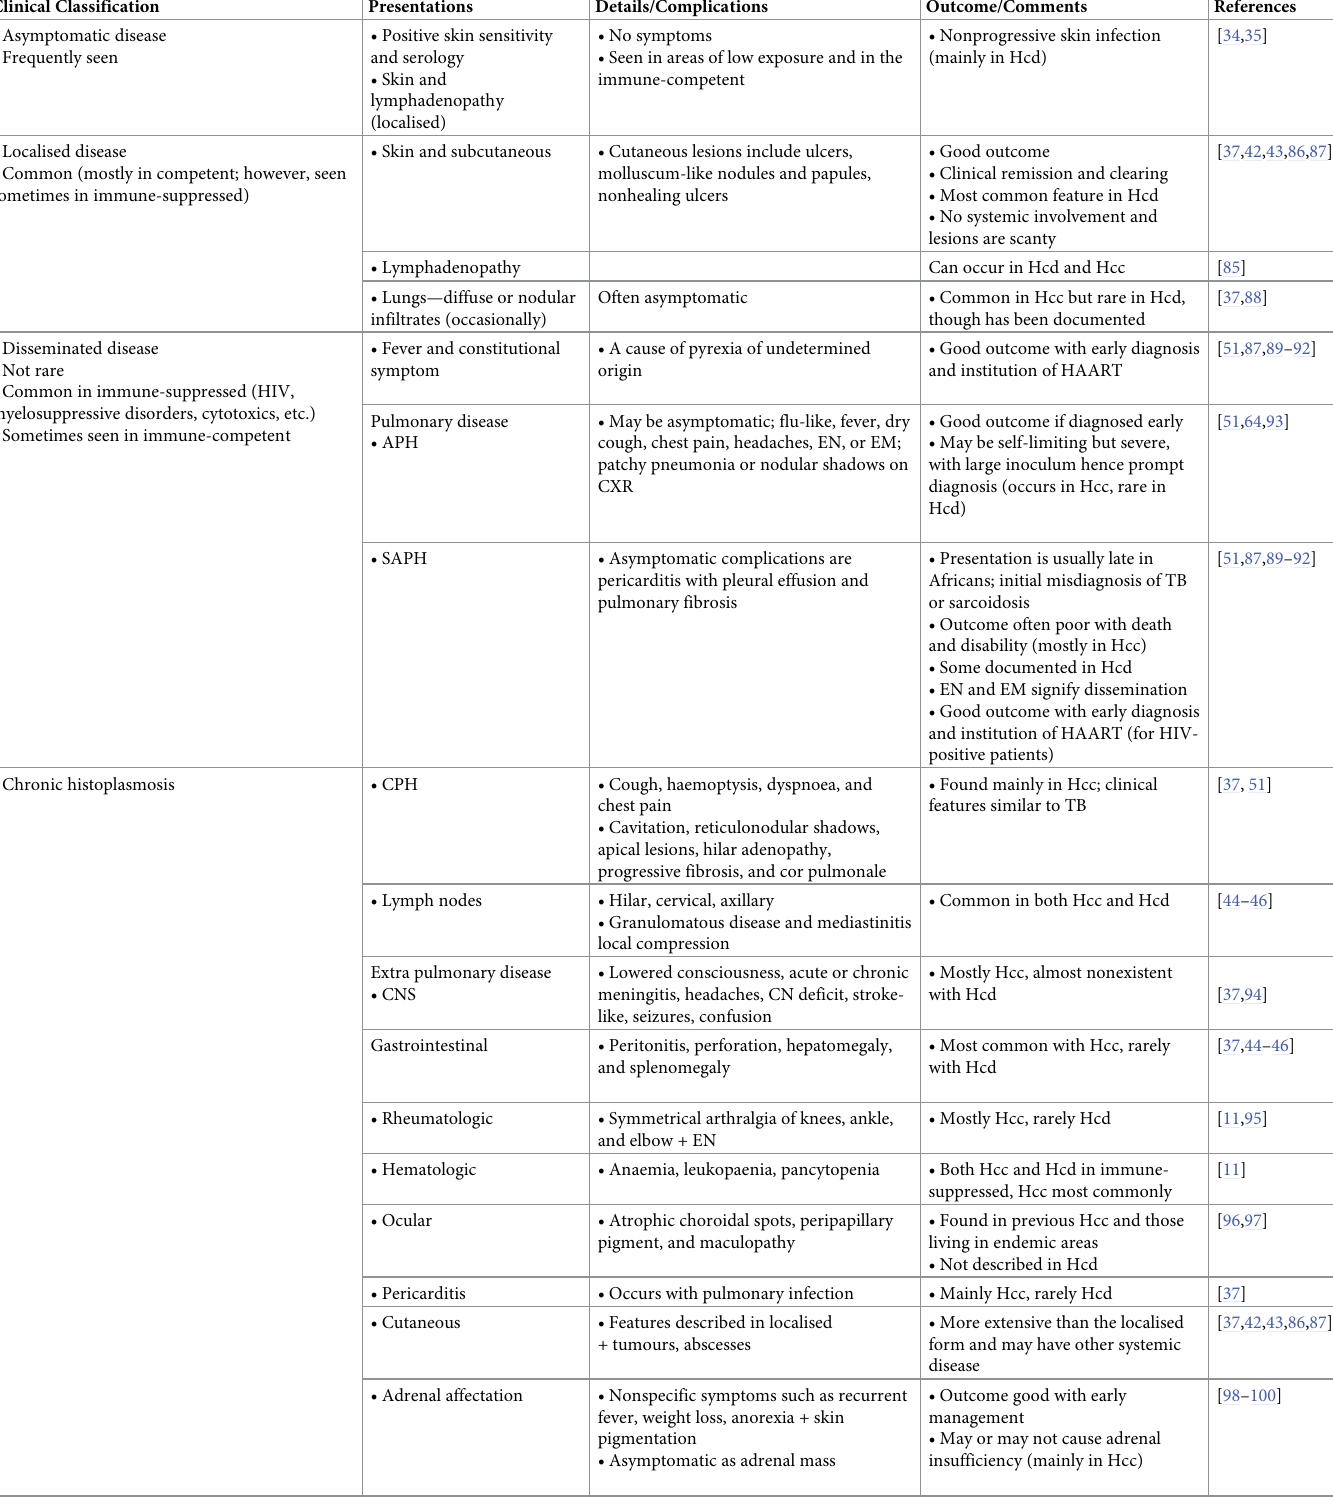
Table 2. Clinical presentation of histoplasmosis in